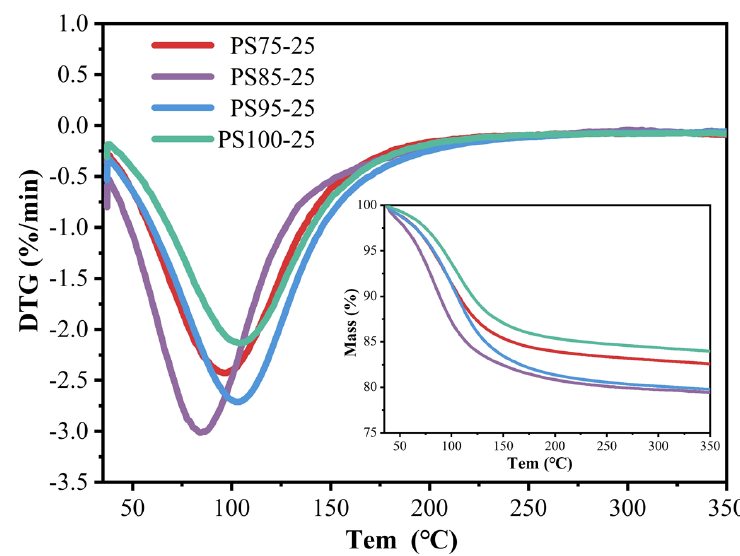
Figure 8. TG-DTG curves of WUFA-PS with different WUFA substitutions and PS-based geopolymer at 28 days.